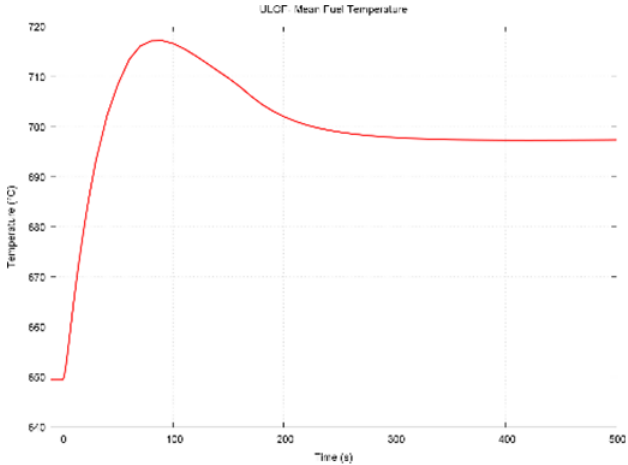
Fig. 8. Mean fuel